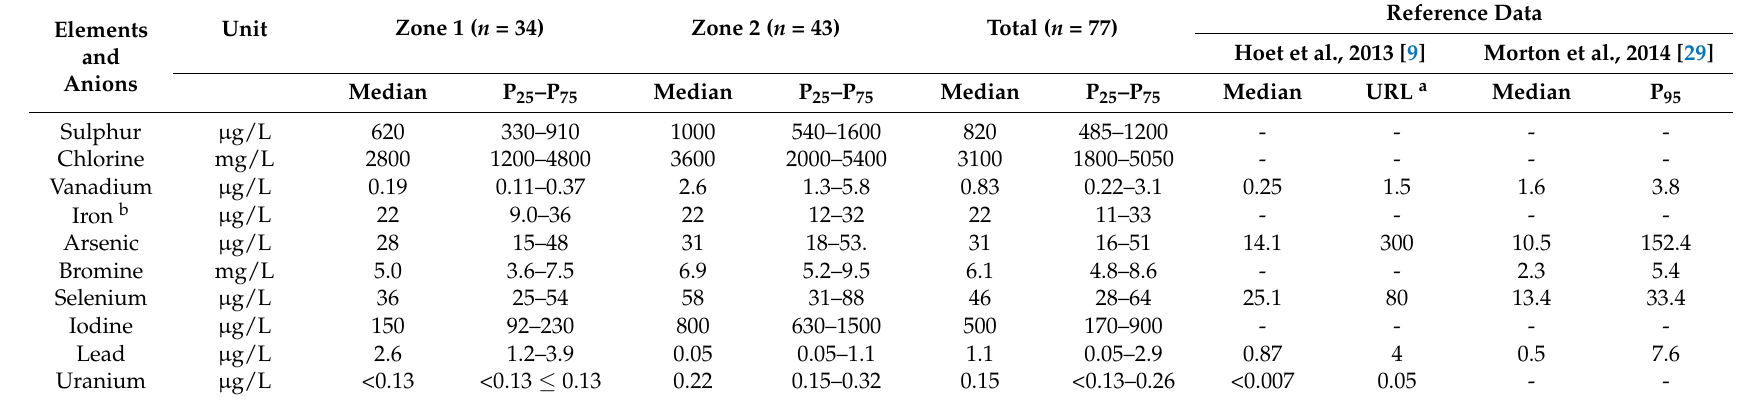
Table 4. Concentration of elements in urine among Saharawi women living in Zones 1 and 2 in comparison with other published data. Elements